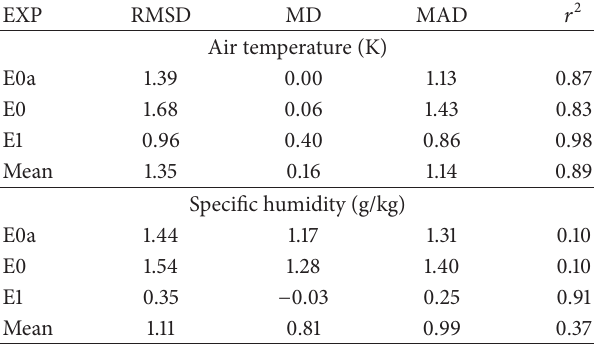
Table 7: Overview of ENVI-met’s performance in simulating air temperatures and specific humidity on 7, 23, 2013. For further explanations refer to Table 5.